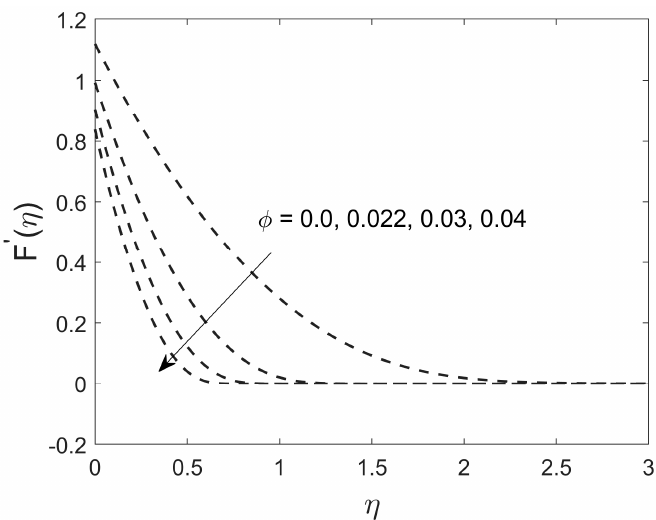
Figure 5. Effect of the radius of curvature on the velocity profile.